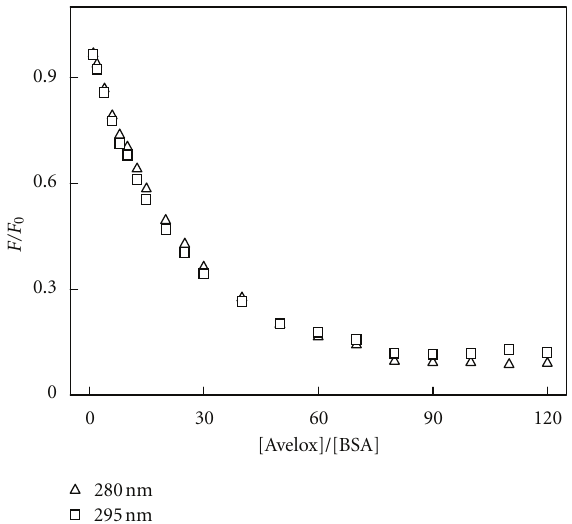
Figure 4: Quenching curves of BSA-Avelox system at λ ex = 280 nm and 295 nm C BSA = 1.0 × 10 − 6 M, C Avelox = 1.0 × 10 − 6 ∼ 1.2 × 10 − 4 M; T =